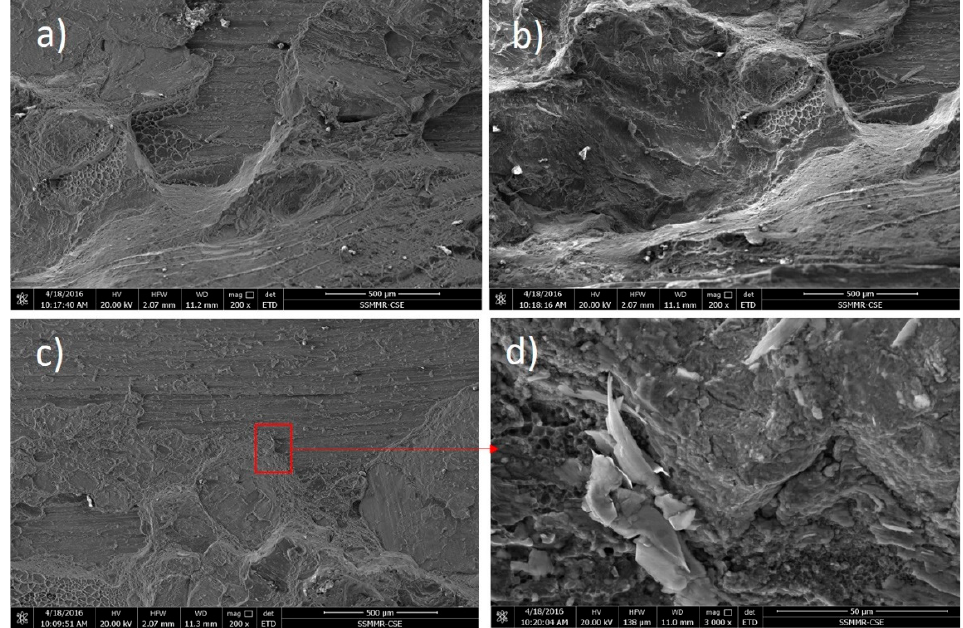
Figure 12. SEM micrographs of the fracture surfaces of FSWed joints welded at 250 rpm and 25 mm/min at different positions: ( a , b ) low magnification and high magnification for a mixed fracture mode features and ( c , d ) low and high magnification for high-density IMC positions.